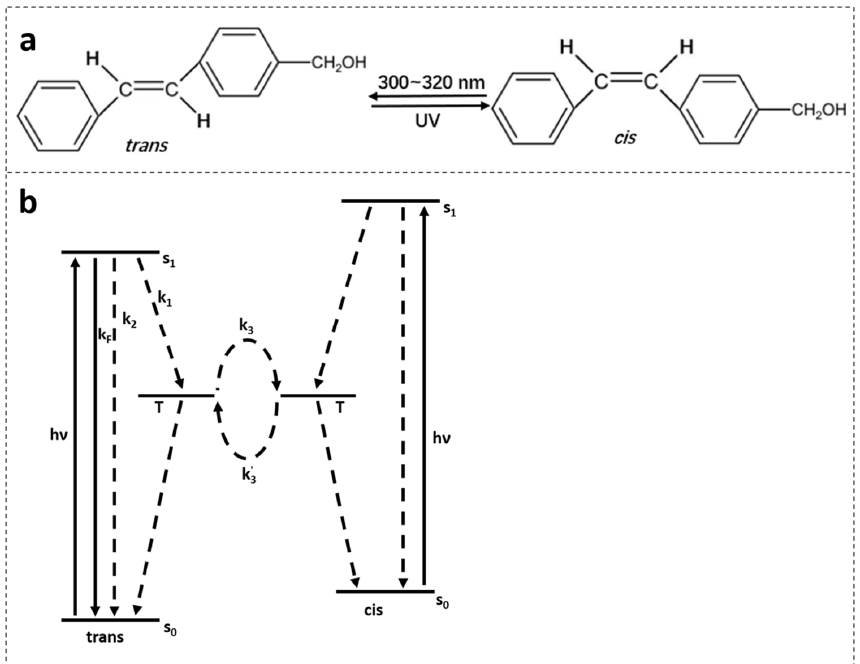
Figure 3. ( a ) 4 ‐ stilbenemethanol isomerization from trans to cis under UV irradiation [27,48]. ( b ) Energy level scheme involved in the photoisomerization process of the TS compound. Reprinted with permission from [29].